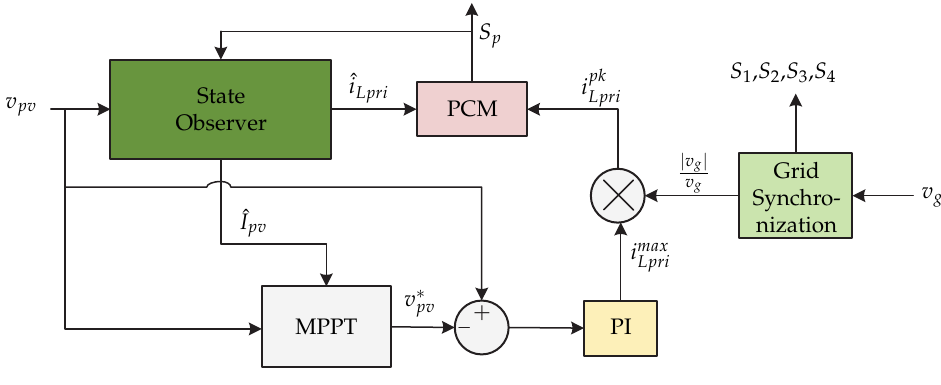
Figure 11. Control strategy proposed in [19,20].